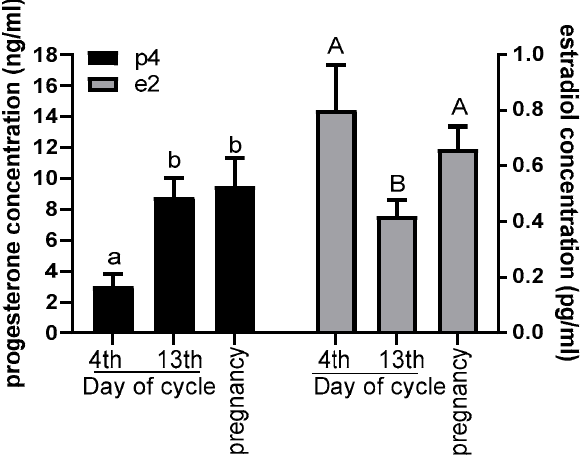
Figure 1. Concentrations of progesterone (left axis of graph; ng/mL) and 17-beta estradiol (right axis of graph; pg/mL) in the blood. Different letters indicate statistical differences in hormone concentrations on the 4th day versus the 13th day of the estrous cycle versus during pregnancy. p < 0.05 was considered significant.